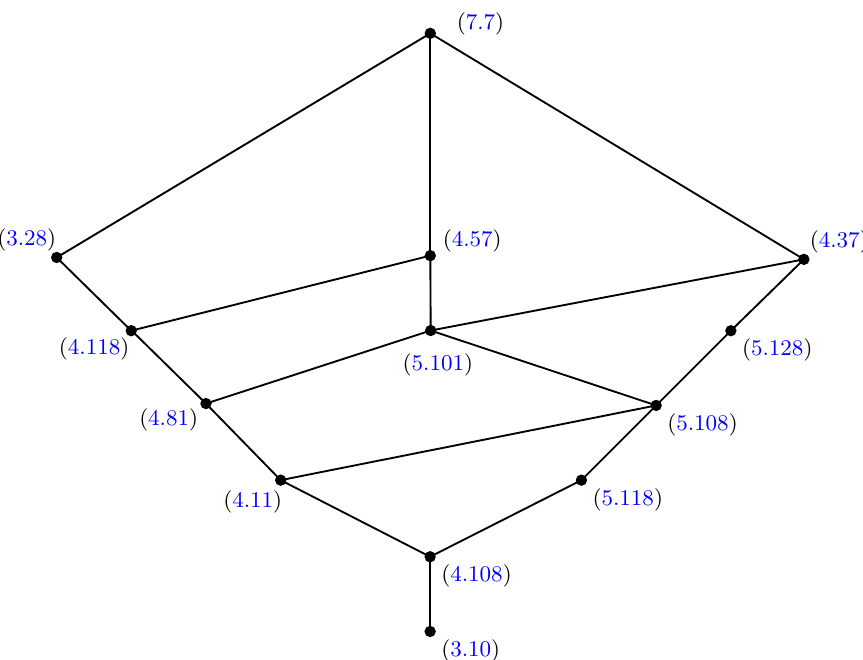
Figure 2. Each point in the Hasse diagram corresponds to a toric diagram, with the corresponding equation number as indicated. Going down along the lines in the Hasse diagram corresponds to the process of